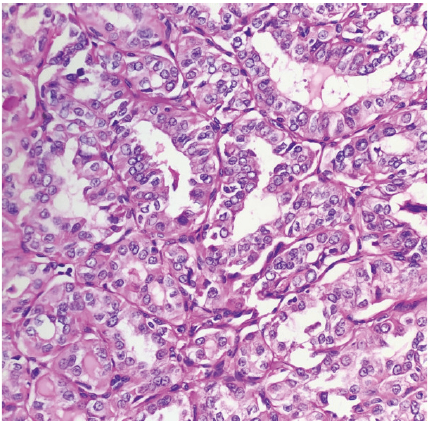
Figure 4: Nuclear grooves with glassy nucleus, peripherally located prominent nucleolus, and nuclear overlapping seen typical for papillary thyroid carcinoma on hematoxylin and eosin staining. H&E